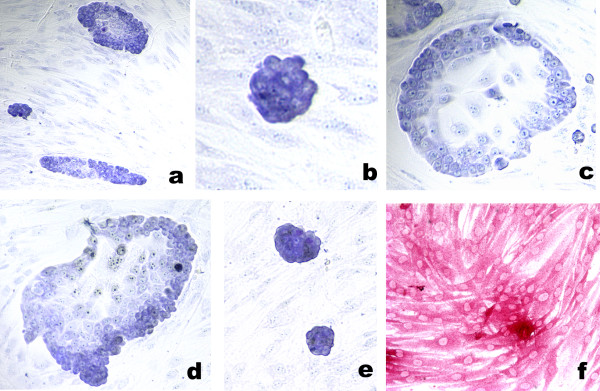
Photomicrographs of tumor cell colonies (3a-e) and fibroblasts immunostained for FGF-7 (3f). In the absence of heparin, breast cancer cells co-cultured on a monolayer of fibroblasts generally produced irregularly shaped large clusters of tumor cells (3a). When heparin was added to the co-culture system, the tumor cells generally formed compact clusters (3b). FGF-7 added to the co-culture system resulted in large glandular-like structures composed of a peripheral rim of compact tumor cells and a central core of plate-like epithelial cells (3c, d). Heparin completely reversed the effects of FGF-7 and produced small compact clusters of darkly staining tumor cells (3e). Immunostaining for FGF-7 (3f) confirmed the abundant presence of FGF-7 (pink stain) on the membrane of the fibroblasts. Toluidine blue stain (3a-e).